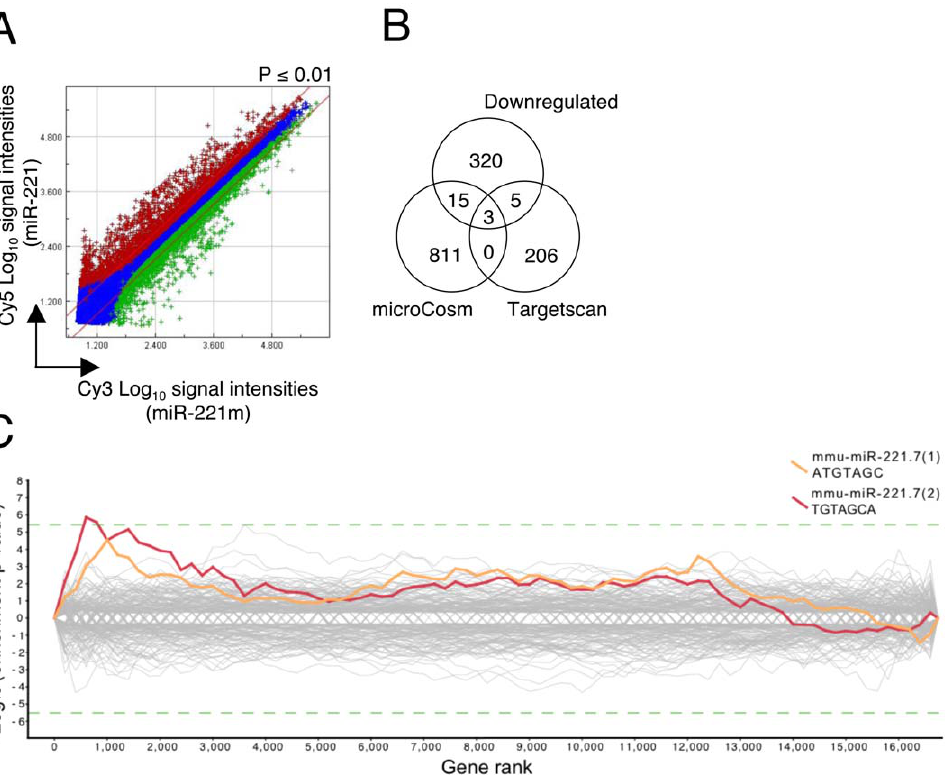
Figure 3. Identification of genes dysregulated upon miR-221 overexpression in BMMCs. A ) Double-log scatter plot comparing the differential expression of mRNAs in BMMCs transduced with the miR-221 and miR-221m. Red diagonal lines define the areas of 2-fold differential signal intensities. Blue cross: unchanged genes. Red cross: significantly upregulated genes (p-value , 0.01). Green cross: significantly downregulated genes (p-value , 0.01). B ) Comparison between significantly downregulated genes and genes predicted to be miR-221 targets by microCosm and Targetscan. C ) Sylamer plot analysis for the Seed Complementary Region (SCR) words corresponding to the seed of miR-221 (red) and its one- nucleotide shifted sequence (orange). Log 10 - transformed and sign-adjusted enrichment P values for each SCR word, relative to P values of all other words, are plotted on the Y-axis, against the ranked gene list on the X-axis (left, downregulated genes; right, upregulated genes). The dashed green line defines the Bonferroni corrected p-value cutoff for significance of 0.05.